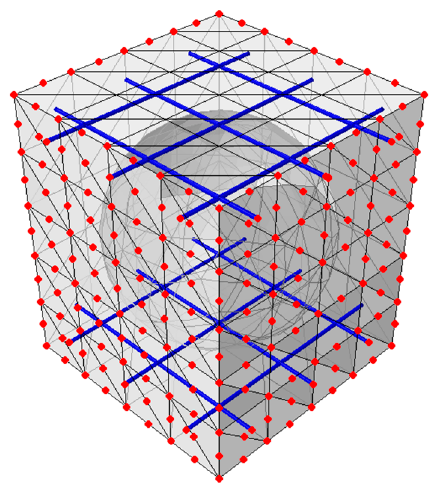
Figure 3. RVE—external (in red color) and internal